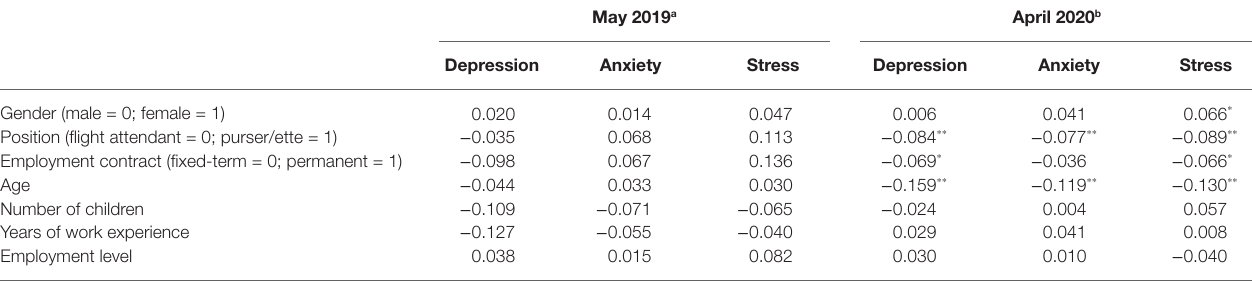
TABLE 7 | Correlations between depression, anxiety and stress with characteristics of the persons.